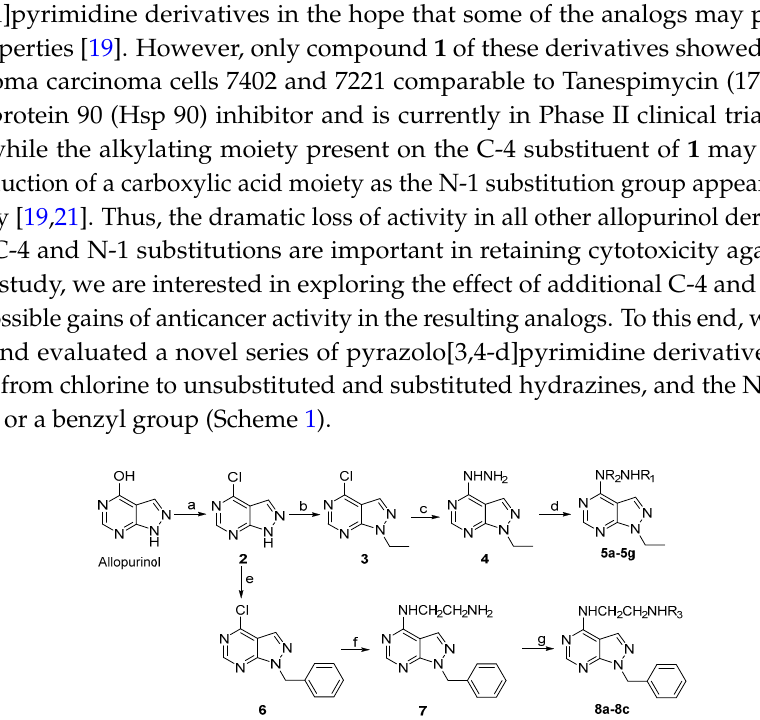
Figure 1. Structures of allopurinol, compound 1 , PU3, and